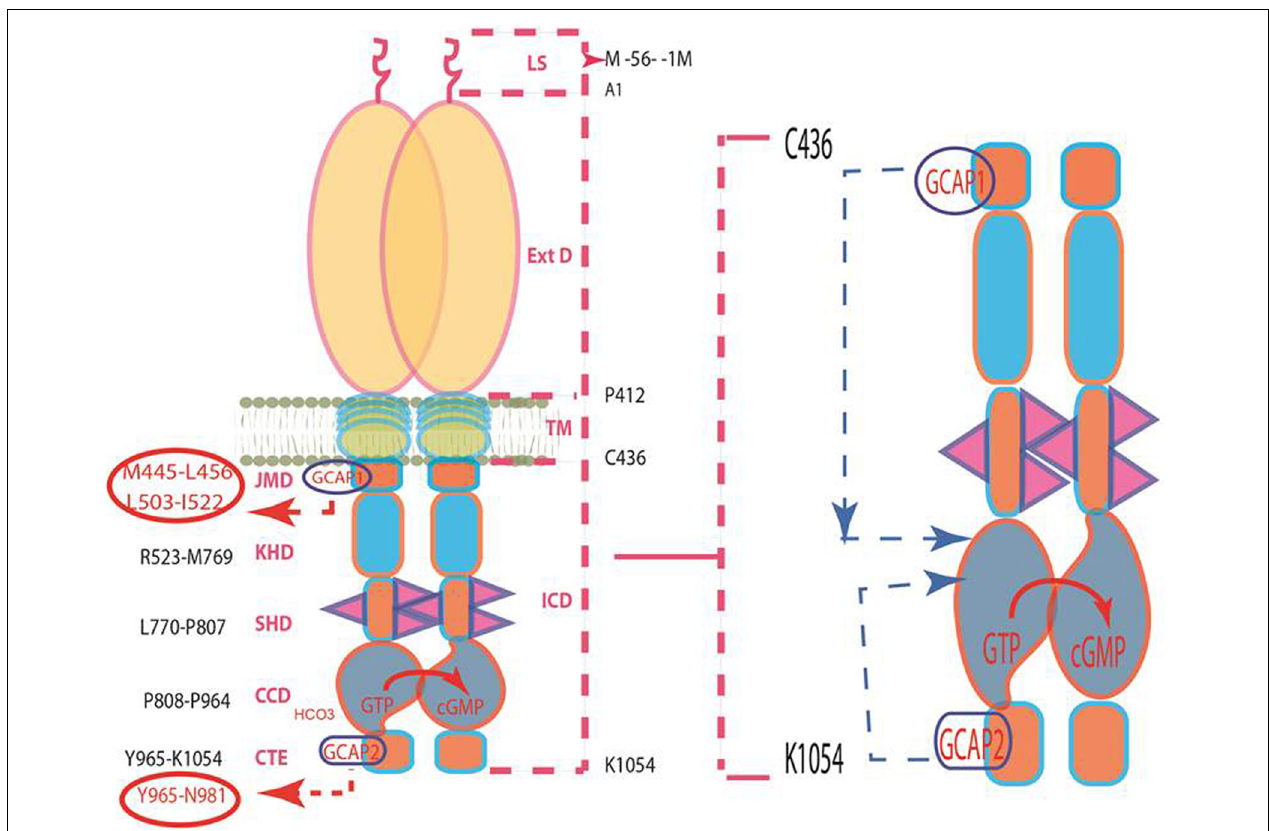
FIGURE 4 | Pathways of GCAPs signaling of ROS-GC1 activity. Left panel: Schematic representation of the structural topography of ROS-GC1. It is a single transmembrane homodimer protein. The dashed lines on the right show the defined boundaries of its segments: LS, leader sequence; ExtD, extracellular domain; TM, transmembrane domain; ICD, intracellular domain. All its functional domains are housed in ICD; their designated names and the amino acid residues constituting their boundaries are indicated at the left: JMD, juxtamembrane domain housing the indicated GCAP1-targeted domain; KHD, kinase homology domain; SHD-signaling helix domain; CCD-core catalytic domain; CTE-C-terminal extension housing the GCAP2-targeted